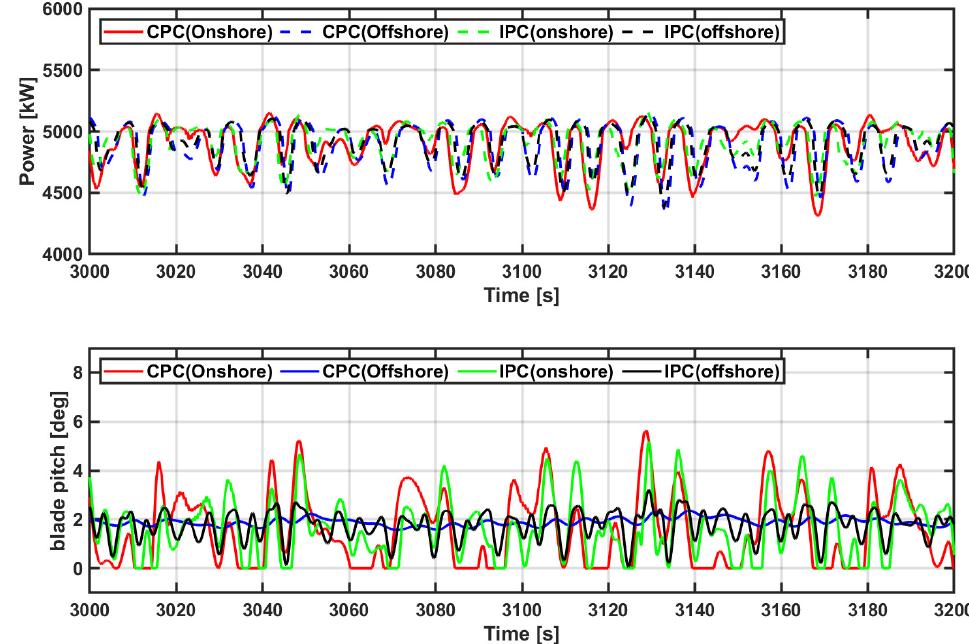
Figure 7. Output characteristics and blade pitch angle of floating offshore wind turbine based on pitch controller.